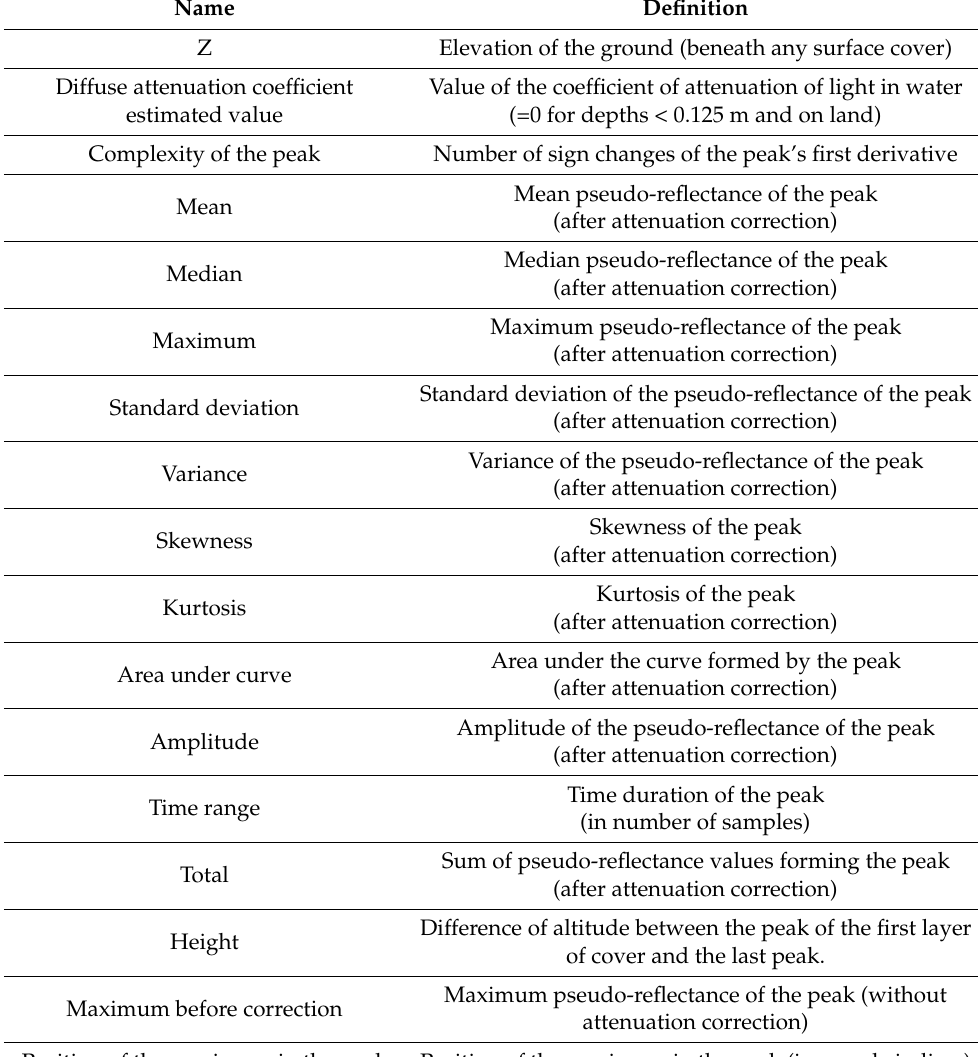
Table 2. Name and definition of the features extracted from the green waveforms during processing and used as input variables to the random forest